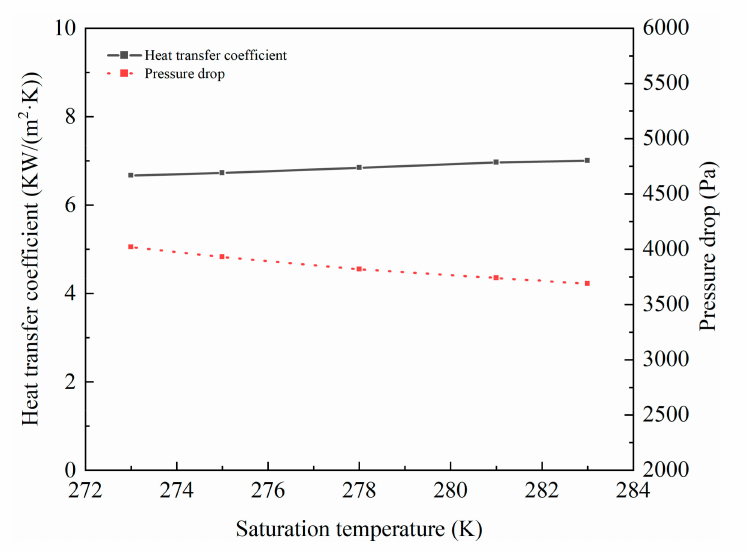
Figure 5. Impact of saturation temperature on the HTC and pressure drop of the smooth